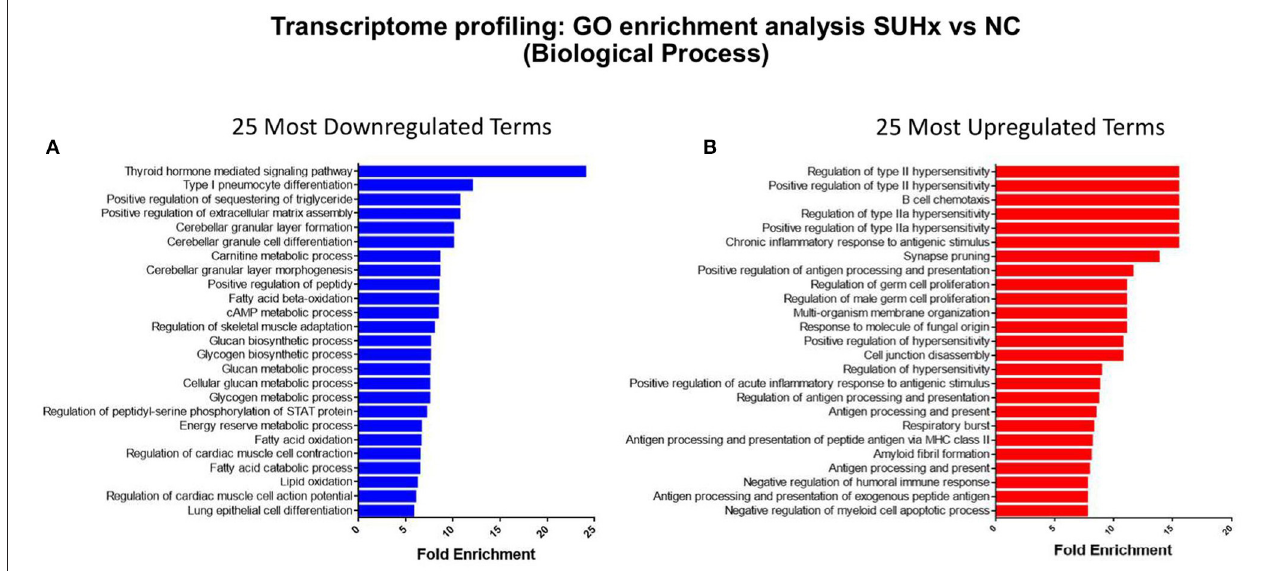
FIGURE 2 | Gene ontology enrichment analysis of biological processes in the RV transcripts between Sugen 5416/hypoxia (SuHx) and control groups. (A) The top 25 most significantly downregulated and (B) the top 25 most significantly upregulated terms by false discovery rate (FDR).